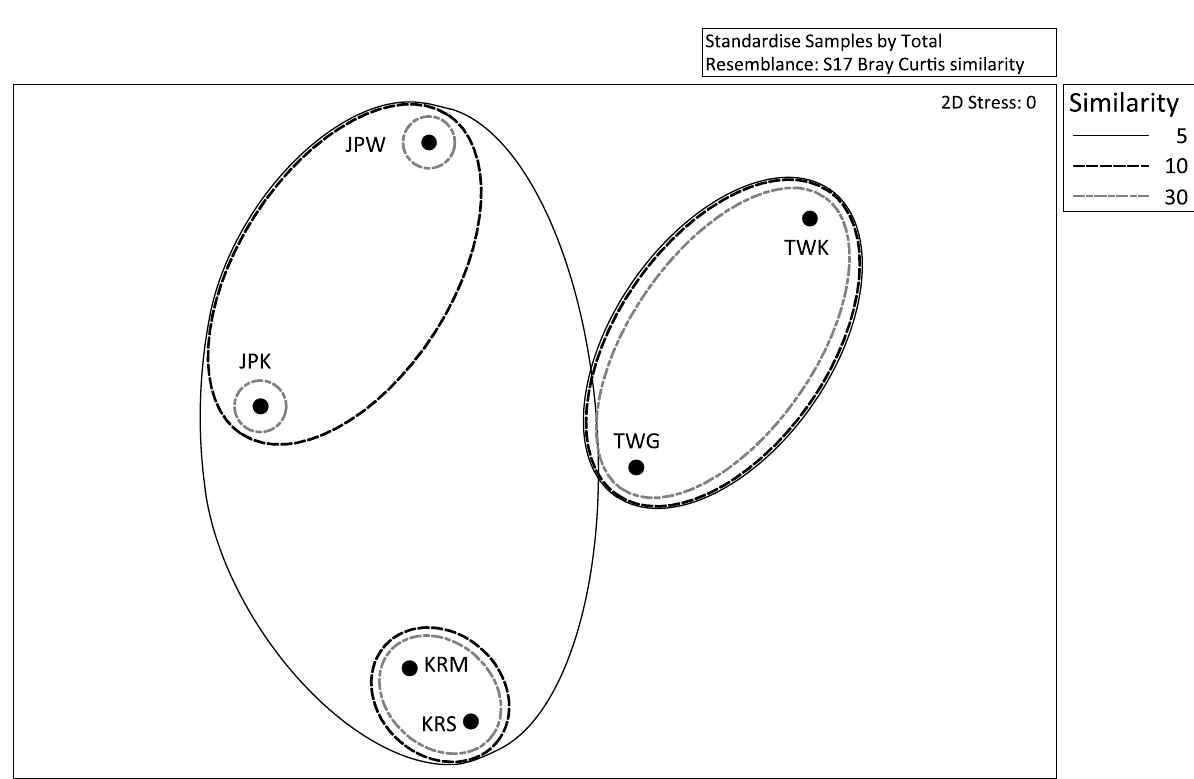
Fig 2. Non-metric multidimensional scaling (nMDS) plot analysis for S . gracillimum -associated samples from various locations. The Bray—Curtis similarity index was calculatedusing the relative percentage of each class in each sample, and nMDS ordinationwas performed in PRIMER 6. The S . gracillimum -associated bacterialcompositionis shown by site: TWG (Green Island, Taiwan), TWK (Kenting, Taiwan), KRM (Moonsum, Korea), KRS (Sungsan, Korea), JPK (Kochi, Japan) and JPW (Wakayama, Japan).